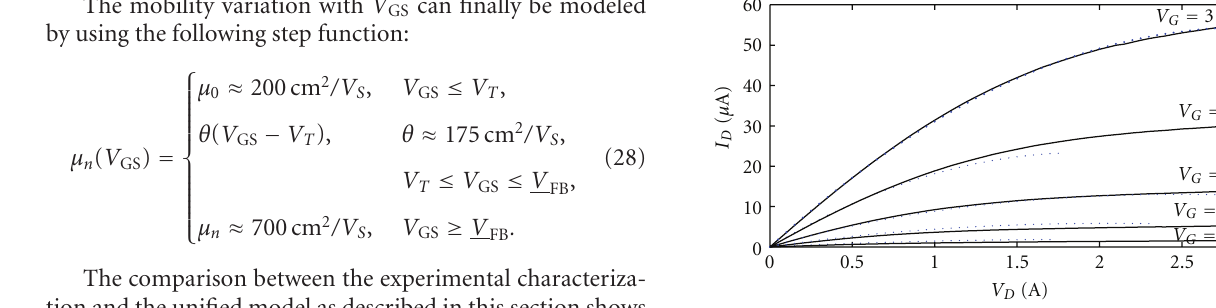
Figure 3: Experimental I DS - V DS characteristics: the measurements are taken in dark conditions (solid lines) for several values of V GS between 3 V and − 1 V. The dotted lines result from the calculated current according to the proposed unified